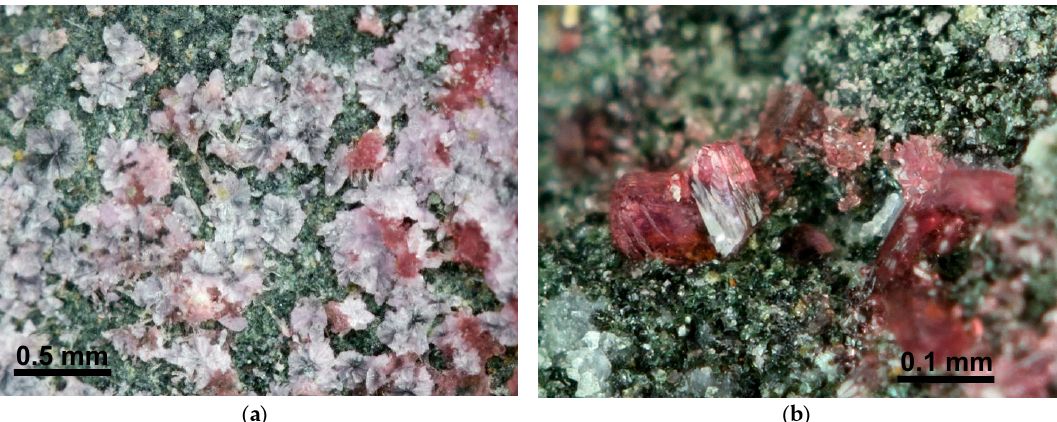
Figure 2. Variation in colour in the erythrite – köttigite series minerals from the Miedzianka polymetallic ore deposit: ( a ) aggregates of köttigite (colourless and white) and erythrite (pink) on the surface of chloritised amphibolite; ( b ) pink erythrite crystal overgrown by colourless köttigite. Minerals 2020 , 10 , x FOR PEER REVIEW